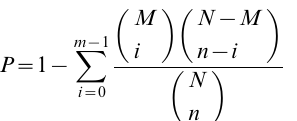
Table S3 Differentially expressed genes between 0 h and 72 h